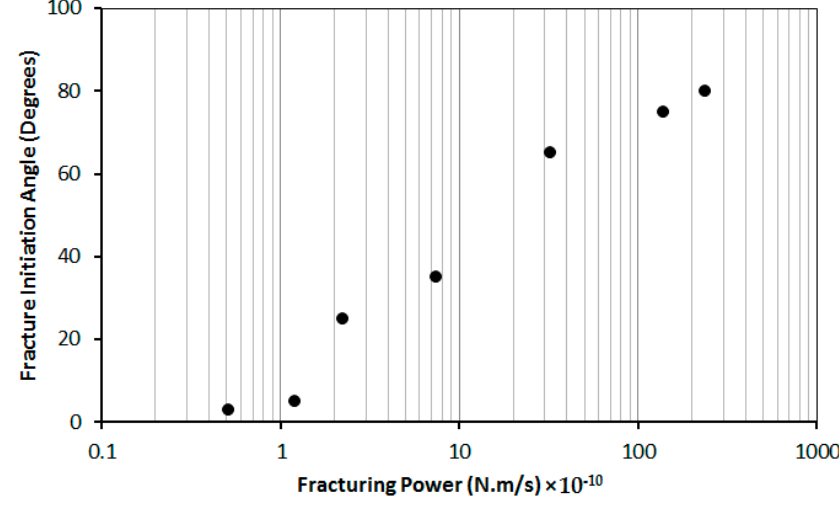
Figure 10. The relationship between the fracture initiation angle and the fracturing power.